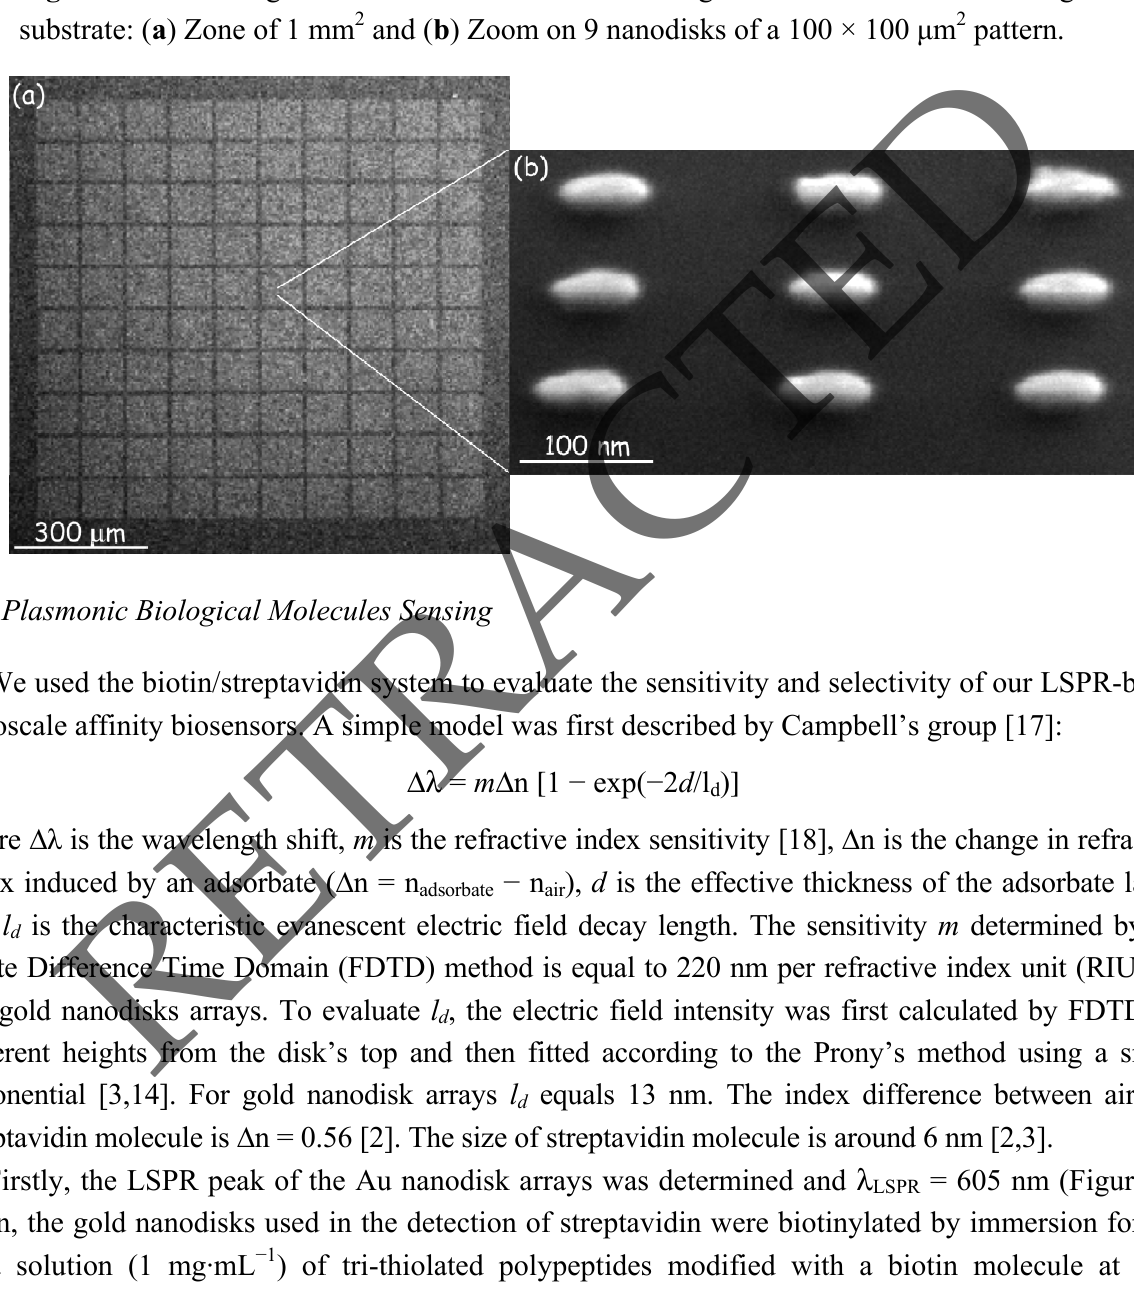
Figure 3. SEM images of Au nanodisks with an average diameter of ~65 nm on a